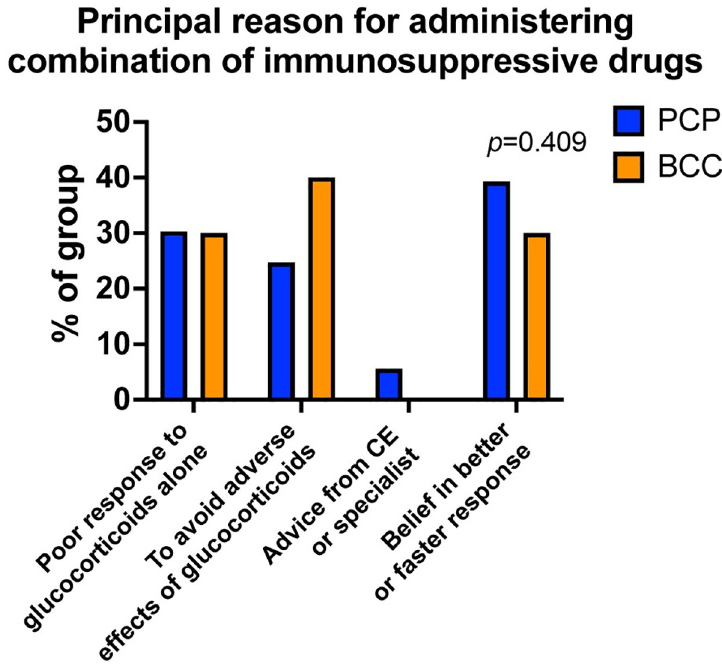
Fig 7. Primary care practitioners and board-certified clinicians use a combination of immunosuppressive drugs for different reasons in the clinic. Bar graph showing the percentage of respondents who administered a combination of drugs principally for the indicated reasons, separated according to group. PCP: primary care practitioner, n = 89. BCC: board-certified clinician, n = 20. CE: continuing education. Groups compared with Chi squared